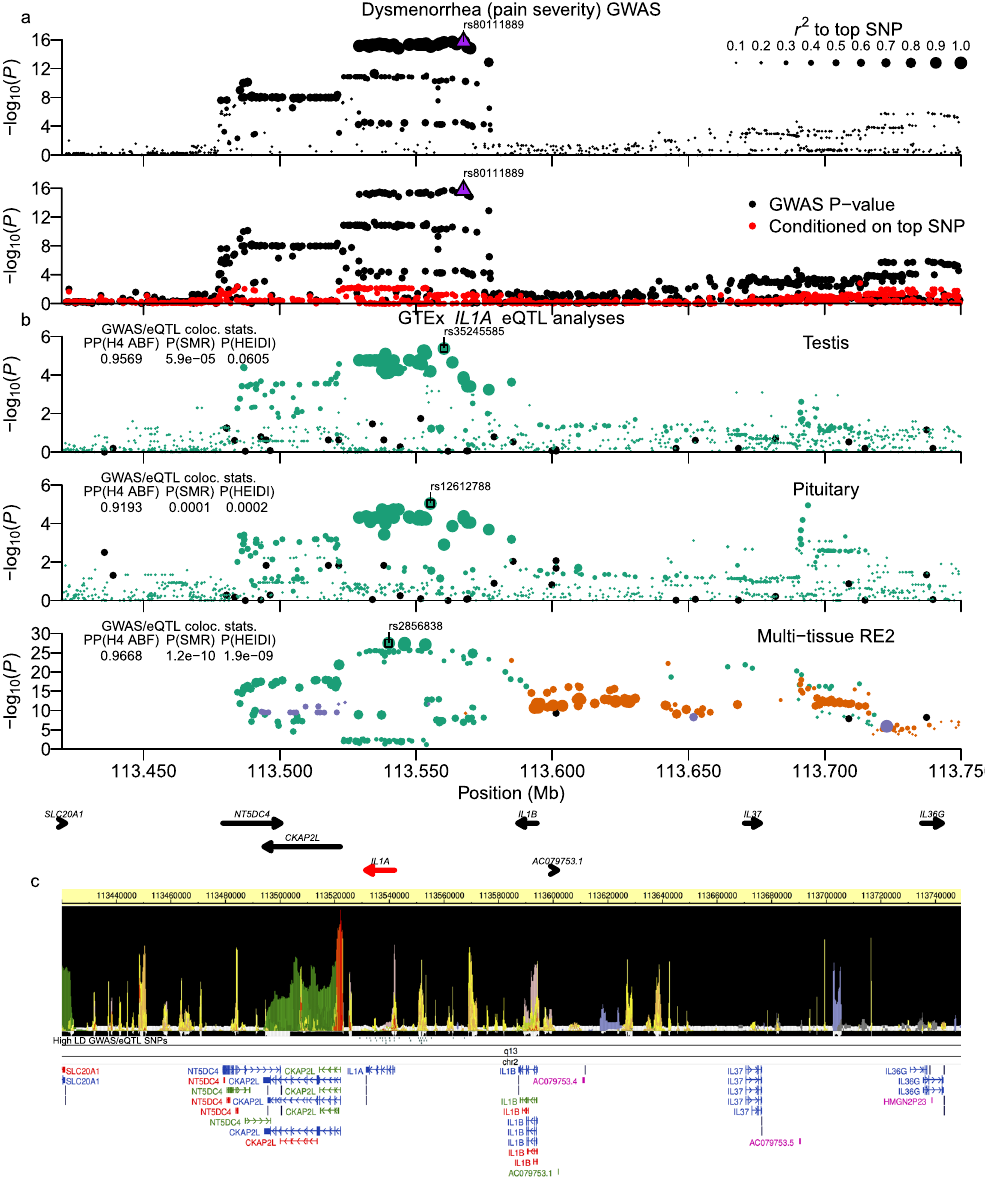
Figure 4. Dysmenorrhea (pain severity) chr2:113.48–113.58 Mb (IL1 gene cluster) locus. Plot is configured the same as Fig. 1. ( b ) shows analyses of GTExPortal IL1A eQTL data. The ABF colocalization method was run using β -coefficients and standard errors. High LD GWAS/eQTL SNPs shown in ( c ) had r 2 equiv > 0.8 to the top GWAS SNP and RSS > 0.8 to top eQTLs in pituitary, testis, and thryoid